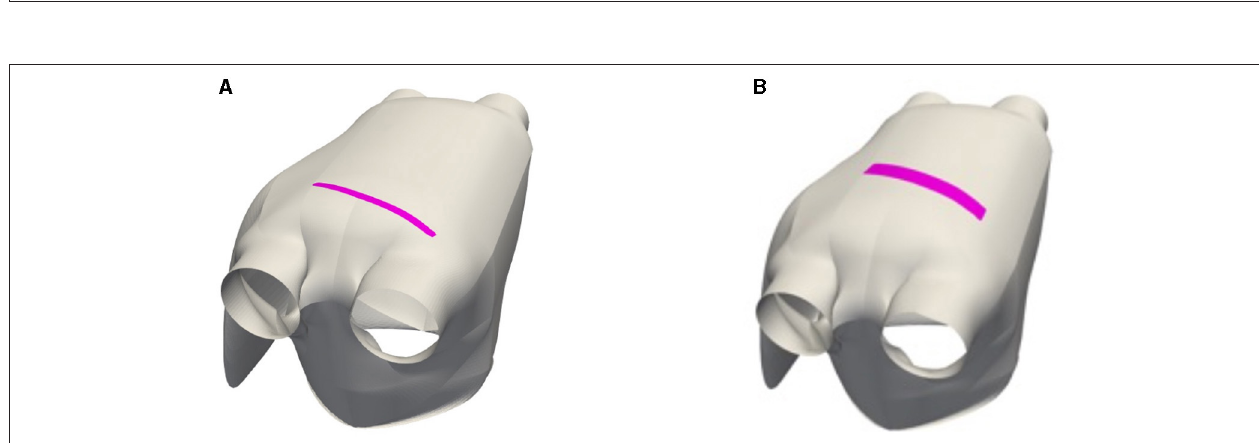
FIGURE 10 | Test 3 : Possible sites of S2 stimulus applications in the case of re-entry dynamics (magenta region) (A) and including both re-entry and non-re-entry dynamics (magenta region) (B) . The coordinates of the points belonging to the highlighted region are the input parameters.